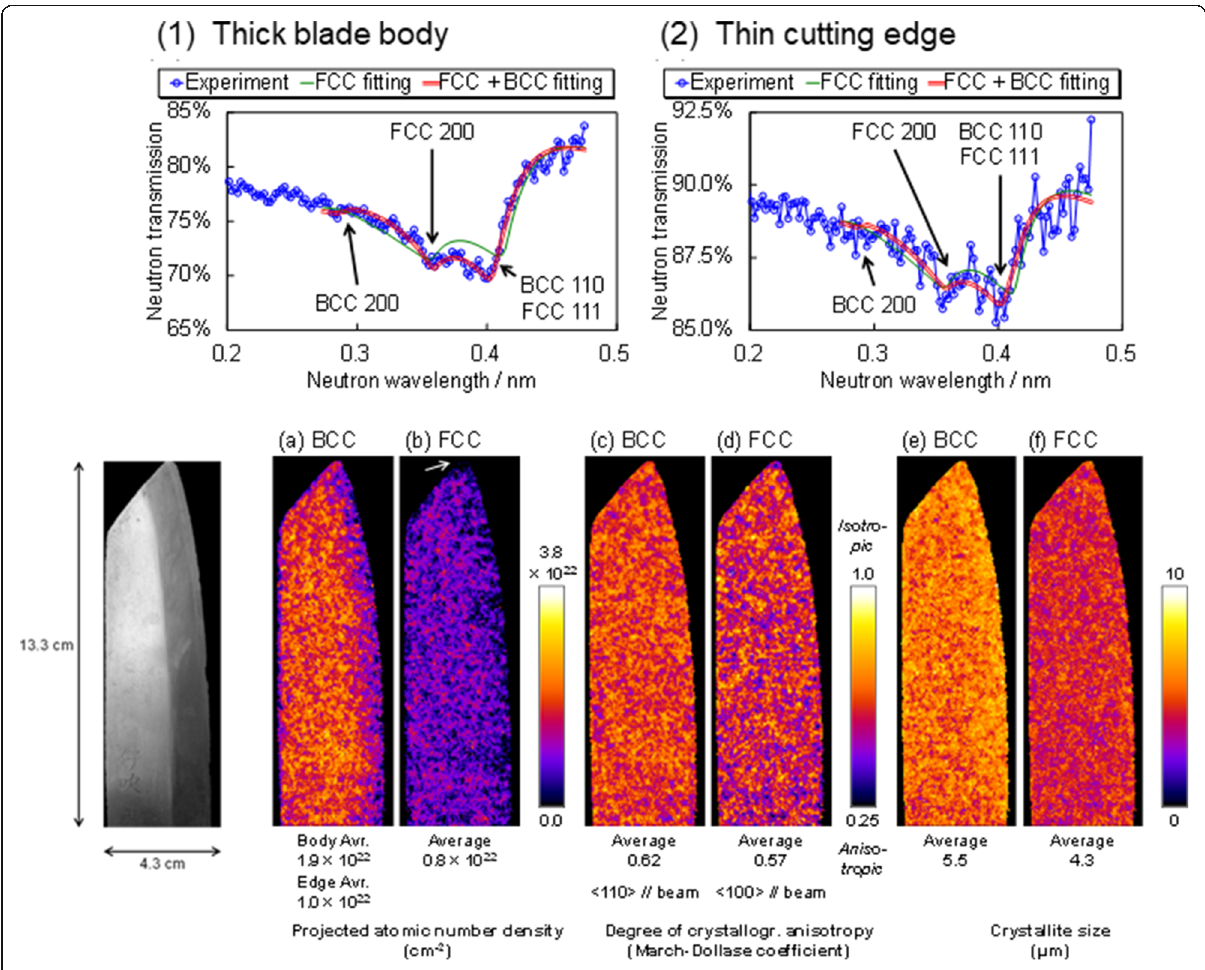
Fig. 10 Transmission spectra of (1) thick body and (2) thin cutting edge in upper figures, and a photo of the knife, ( a ) BCC and ( b ) FCC number density mapping, ( c ) BCC and ( d ) FCC texture mapping, and ( e ) BCC and (f) FCC crystallite size mapping in lower figures